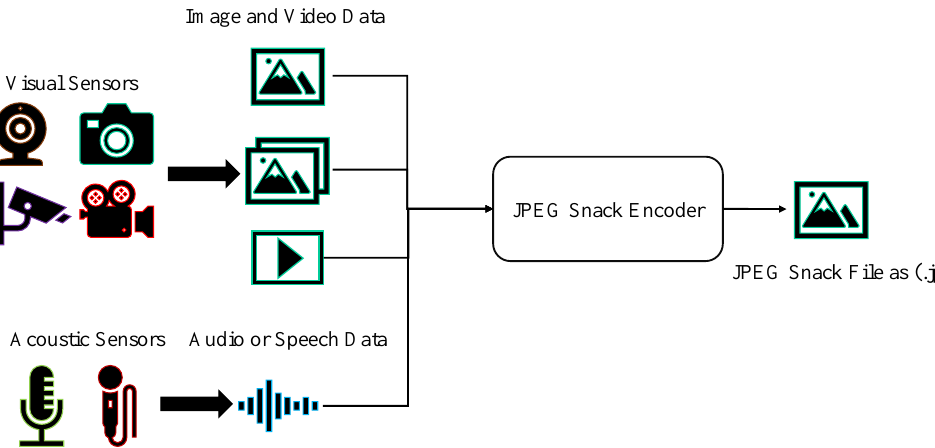
Figure 2. Role of sensors in the JPEG Snack file.